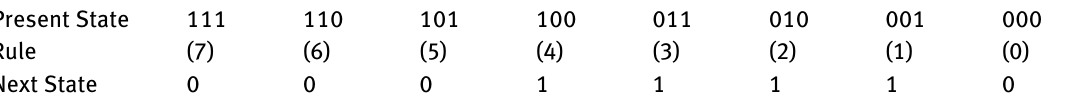
Table 1: Look-Up Table for Rule